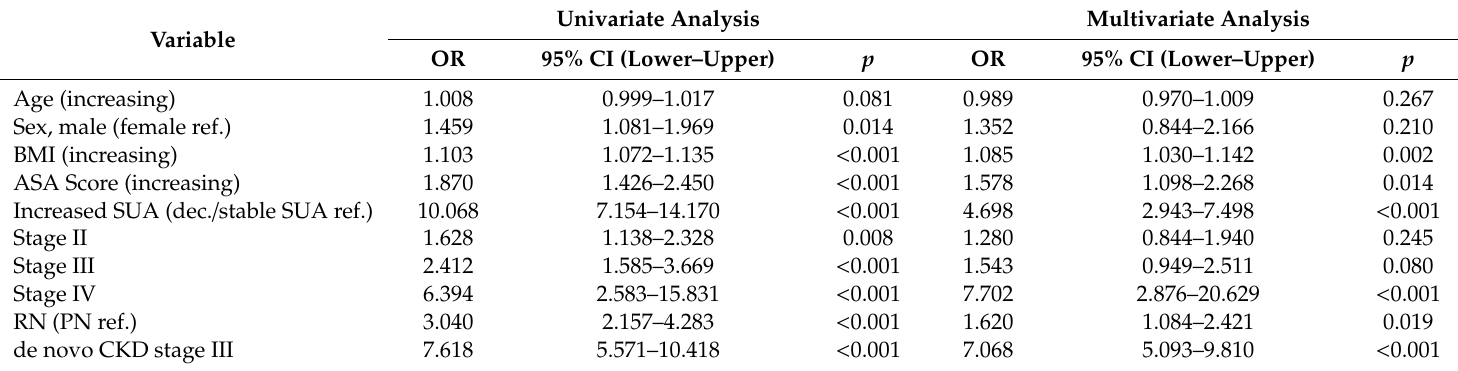
Table 4. Uni- and multivariate regression analysis of risk factors for all-cause mortality. Univariate Analysis Multivariate Variable